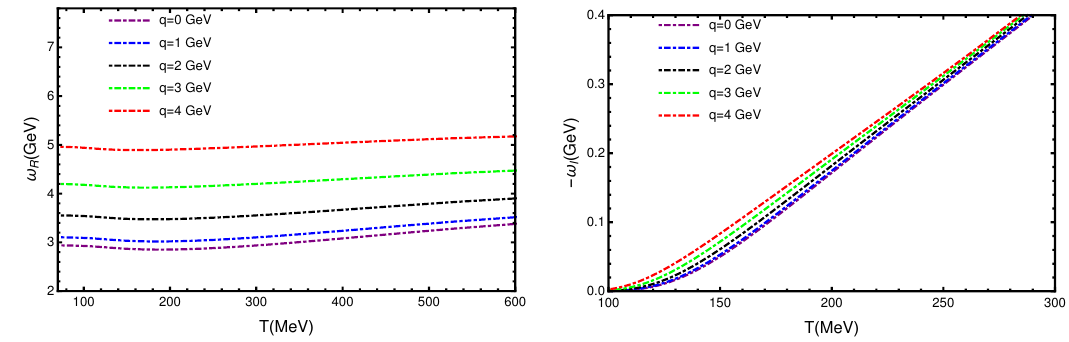
Figure 9 . Numerical results for the quasinormal modes of the charmonium in the transverse direction as function of the